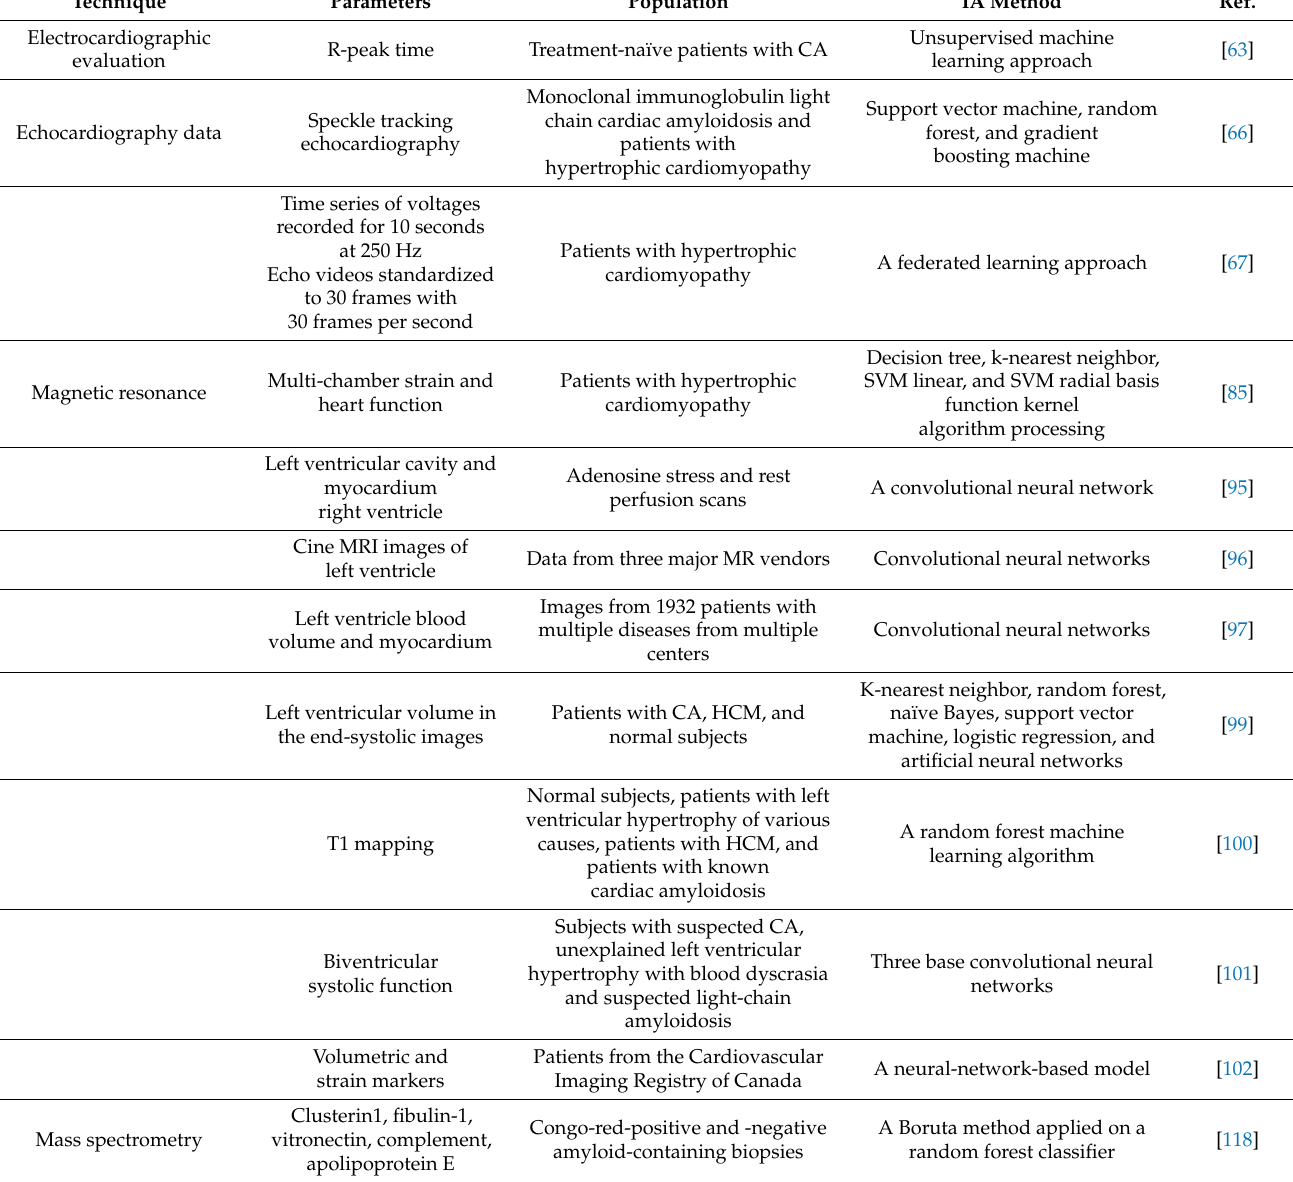
Table 2. Possible ML approaches in the diagnosis of cardiac